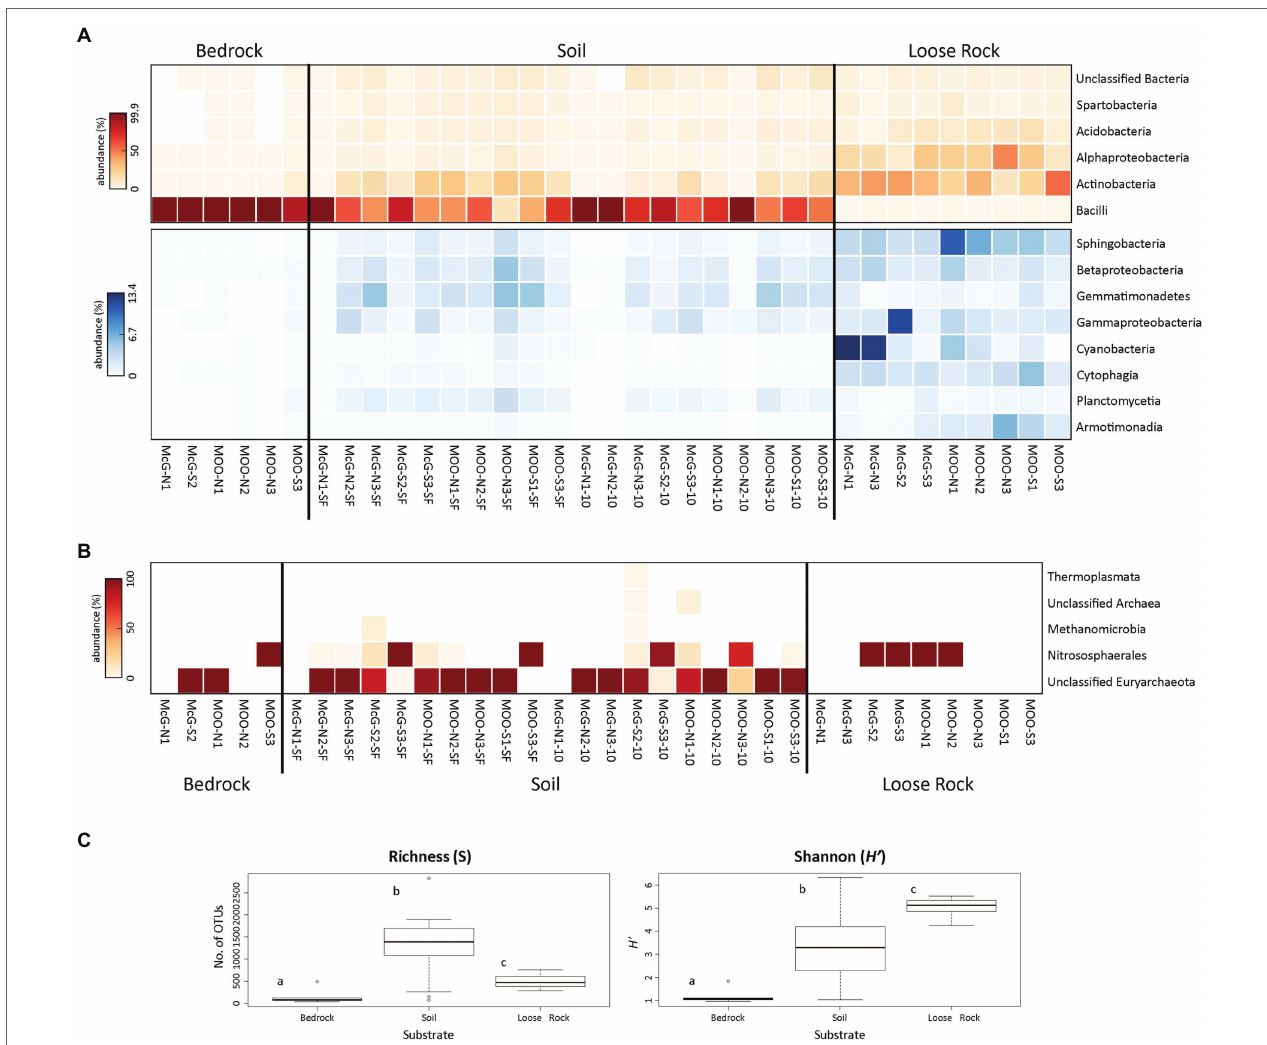
FIGURE 4 | Distribution and diversity of prokaryotic communities among sampling points and substrates. Heat maps showing the relative abundance (number of sequences at the class level) of (A) Bacteria and (B) Archaea (bedrock sample B-MOO-N3 did not yielded any sequence that was classified as Archaea and, subsequently, was not included in the figure). Only prokaryotic classes accounting for >0.5% of total number of sequences are plotted. Bacterial heat maps are split into two to better show the relative abundance of the less represented classes (blue scale). In both the red and blue scales, white color indicates absence of sequences (please notice the different % of abundance in each heat map). (C) Boxplot presenting the Richness (S) and Shannon diversity ( H ' ) indices for prokaryotic communities at each of the analyzed substrates. Different letters depict significant differences ( p < 0.05) among the